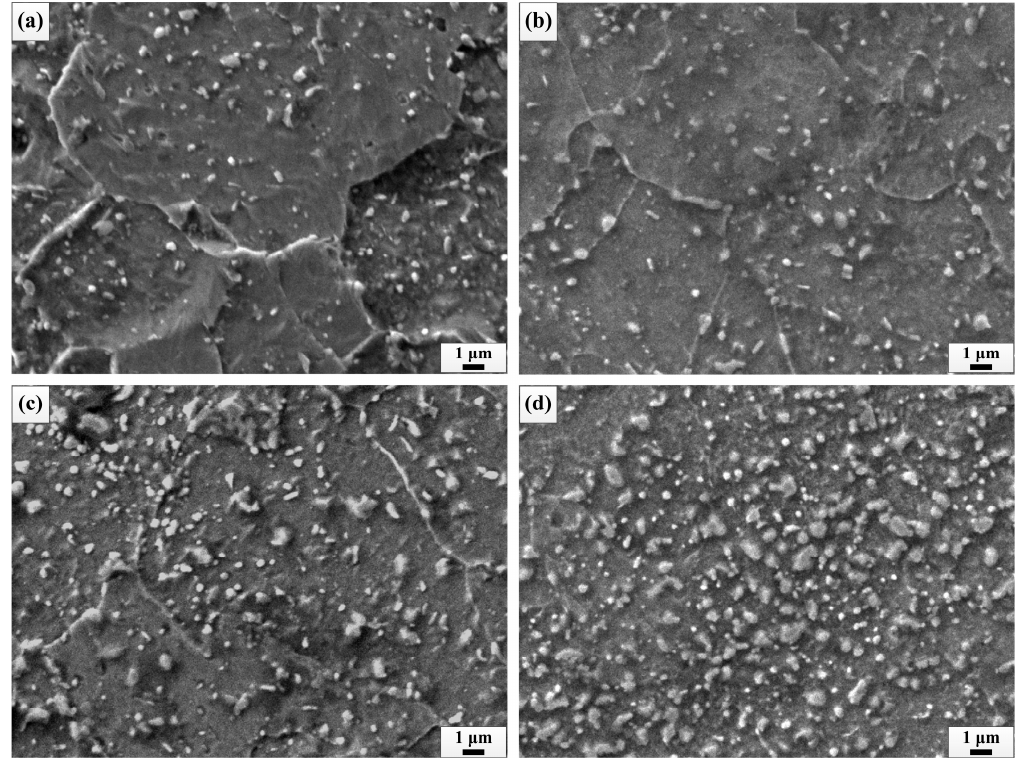
Figure 8. Microstructural evolution of matrix after different numbers of thermal fatigue cycles: ( a ) 0 cycle, ( b ) 400 cycles, ( c ) 800 cycles, and ( d ) 1200 cycles.